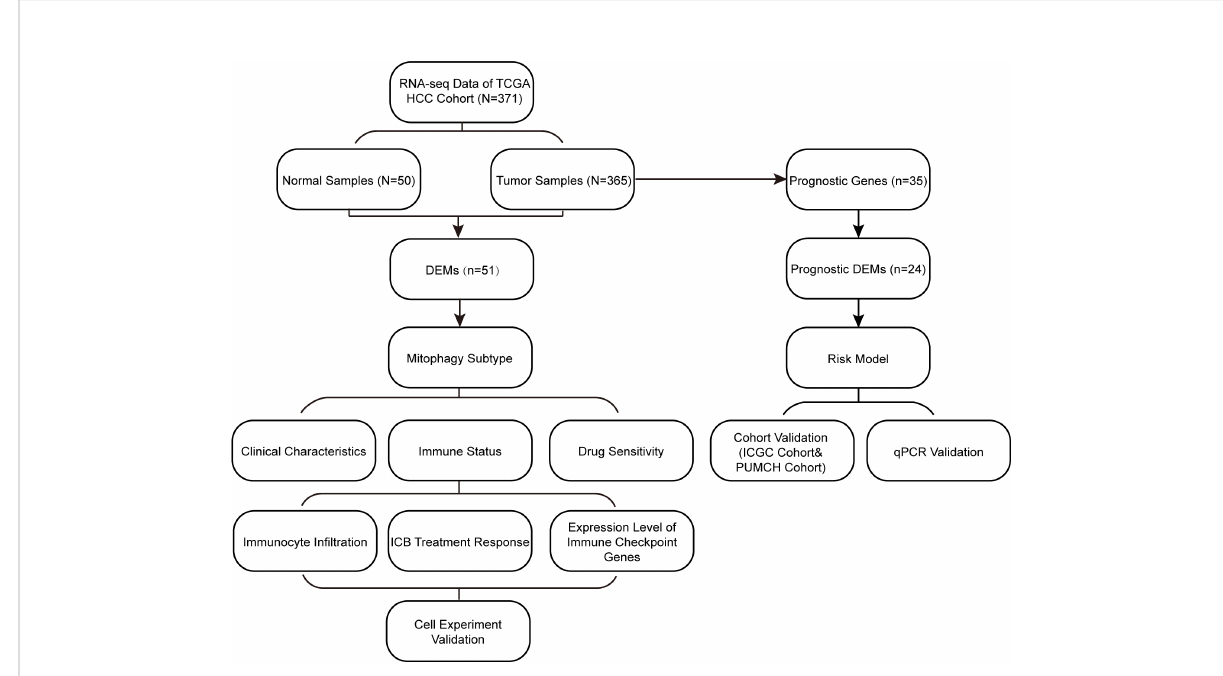
FIGURE 1 Study fl owchart. DEMs, Differentially expressed mitophagy-related genes; ICB, immune-checkepoint